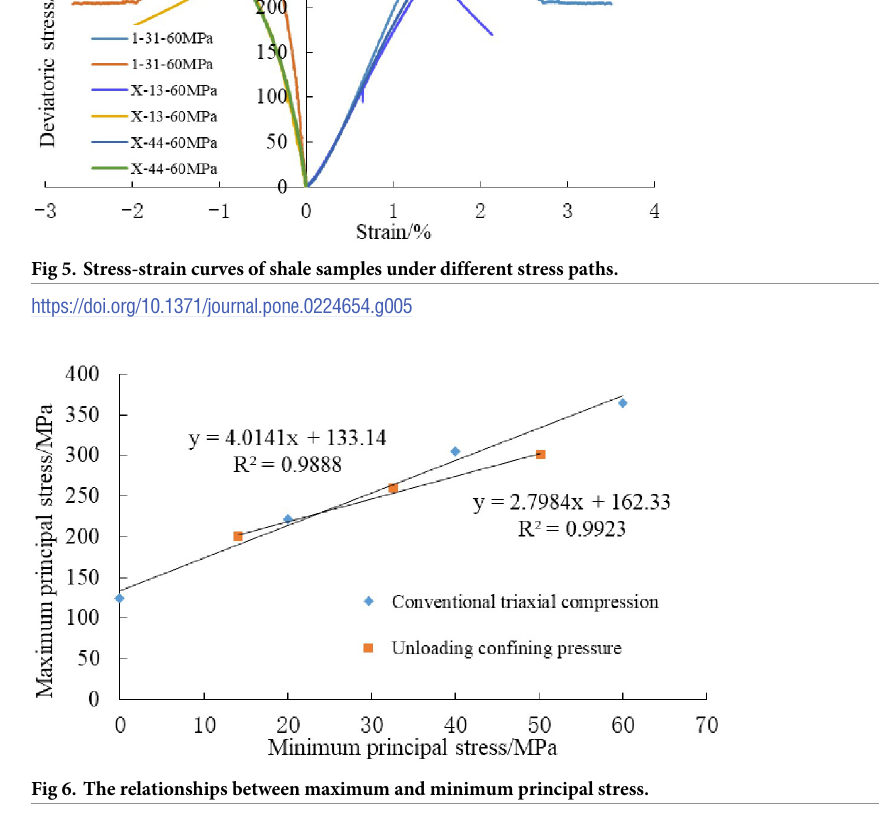
Fig 6. The relationships between maximum and minimum principal